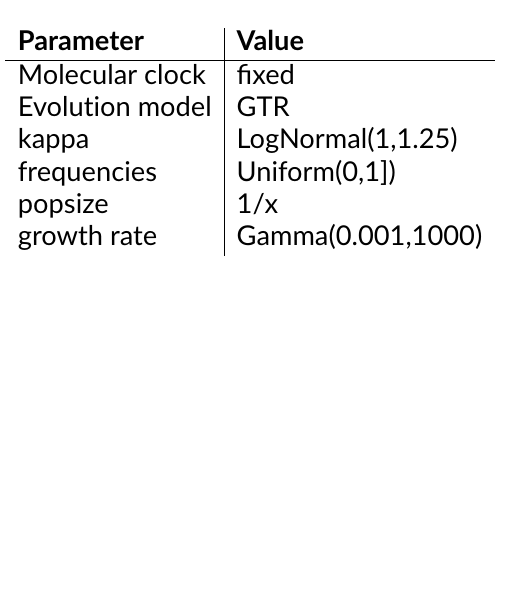
Table S1 – Prior summary for the exponential coalescent model